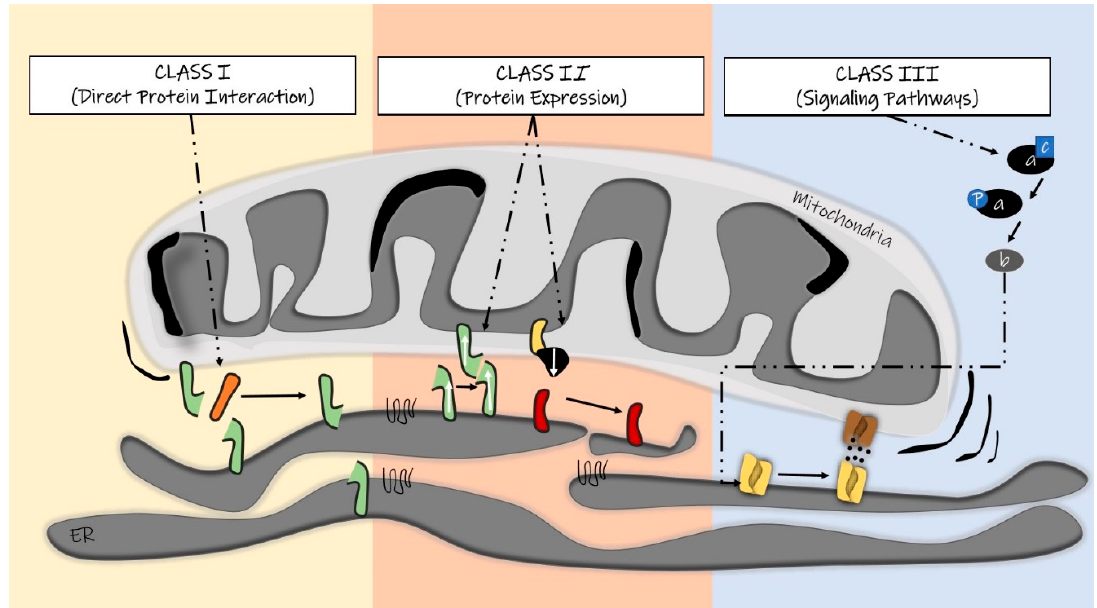
Figure 1. Schematic of the three classes of compounds that could modulate mitochondria–endoplasmic reticulum contact sites (MERCs) structure and function.